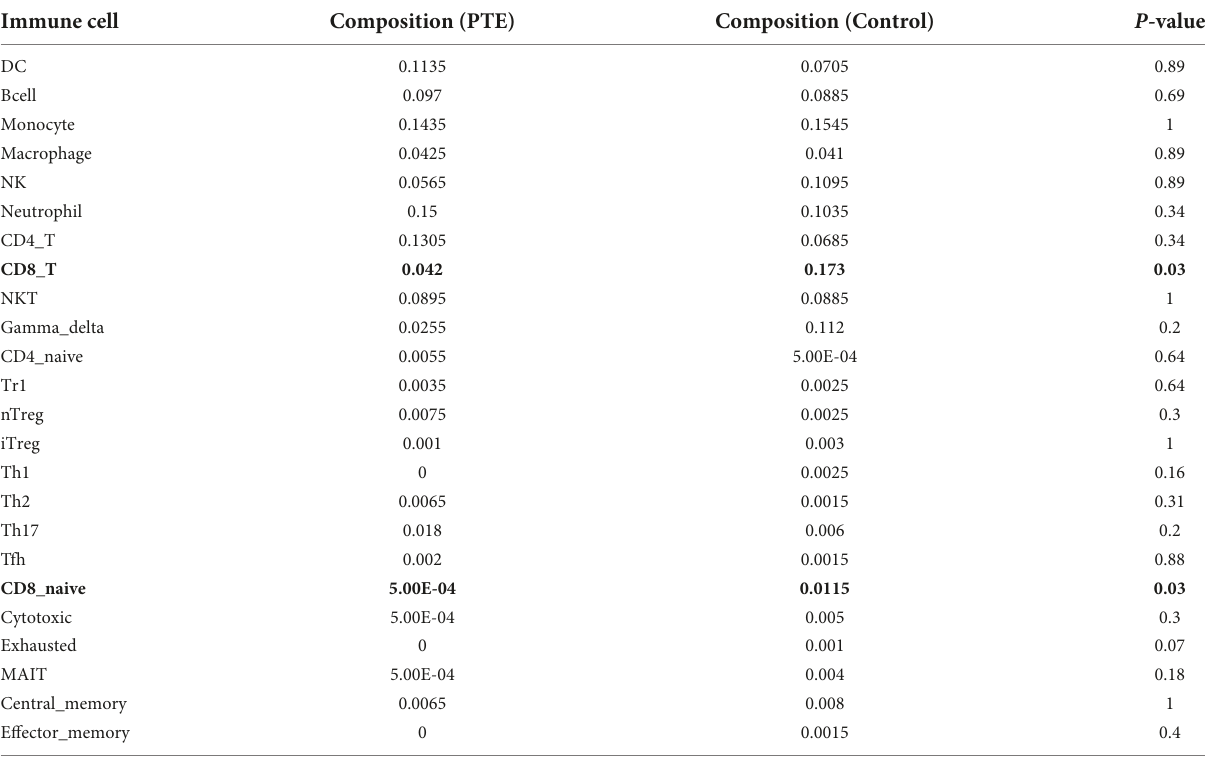
TABLE 3 Comparisons between immune cells in two